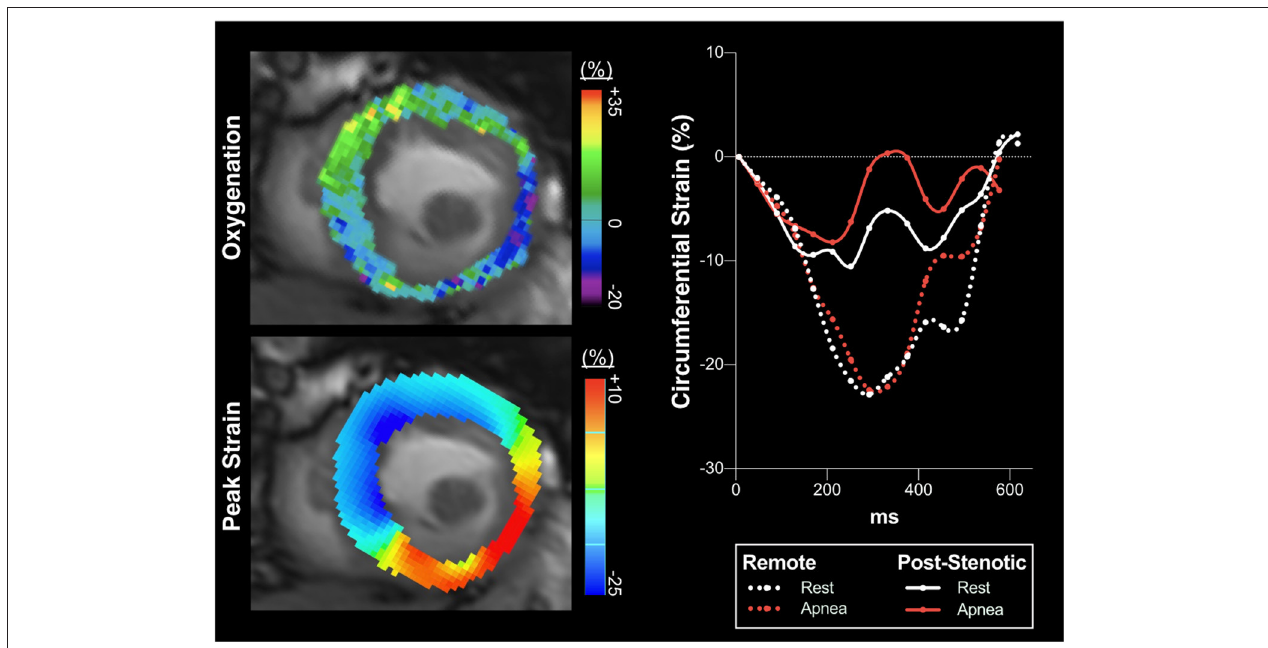
FIGURE 5 | Circumferential strain over the cardiac cycle. In a patient with a full occlusion of the right coronary artery partially compensated for by collaterals, deoxygenation occurs in the inferoseptal, inferior and lateral myocardial segments in response to brief intentional apnea seen with OS-CMR (upper left panel, mid-ventricular short axis slice, blue indicating oxygenation deficits, while green shows a normal response). This is accompanied by impaired peak strain (PS, yellow-orange) of the very same segments during apnea (lower left panel, circumferential strain CMR-FT analysis), while remote healthy myocardial segments display a normal physiologic response. The right panel shows strain over the cardiac cycle averaged for the post-stenotic and remote territories defined by the angiography analysis. While remote myocardium at apnea slightly increased (PS) beyond the resting baseline, the angiographically defined post-stenotic myocardium in the inferoseptal and inferior wall showed an averaged pronounced attenuation of PS represented by less negative strain values indicating aggravating severe hypokinesia to regional dyskinesia (seen also in the left lower panel) of these segments triggered by myocardial deoxygenation during apnea. This patient did not have any reperfused territory. Both native T1 (1381ms) and T2 (44.2ms) mapping were elevated in the post-stenotic